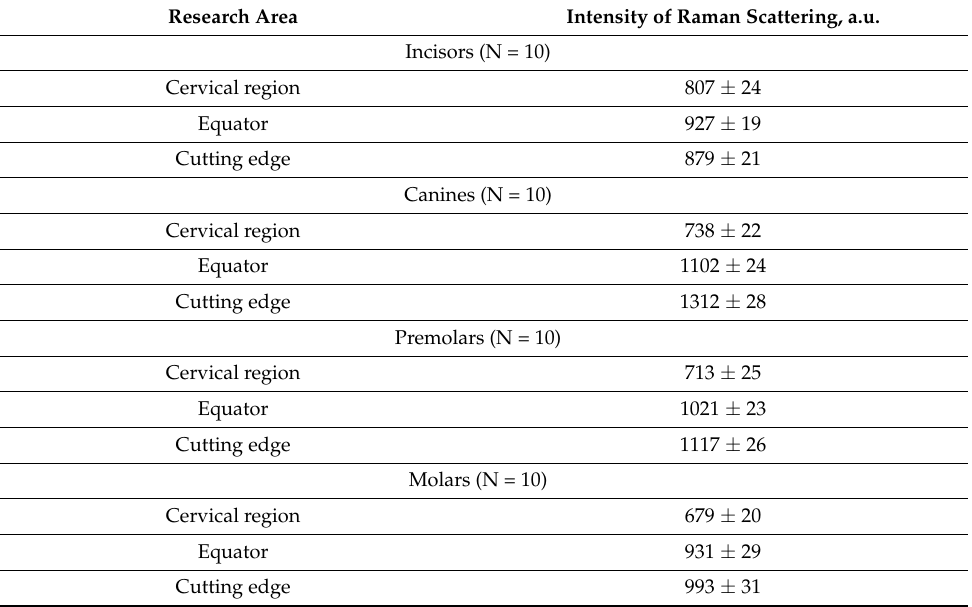
Table 3. The intensity of Raman scattering on different removed teeth, depending on the measure- ment point.